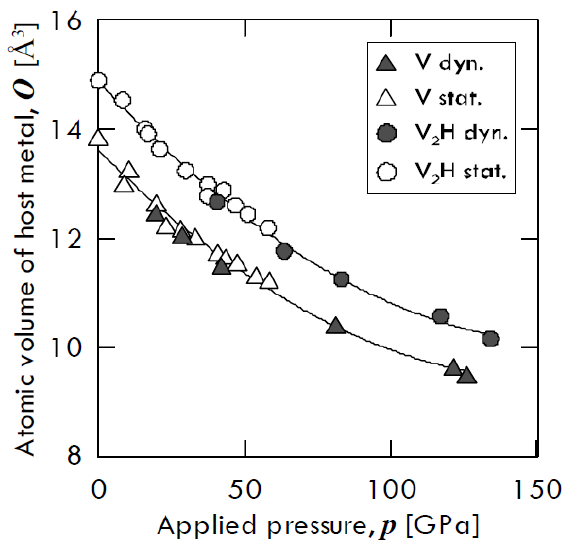
Figure 2. Compression curves of β -V 2 H and pure vanadium. The open symbols refer to static compression data (diamond anvil cell), while the closed ones refer to dynamic compression data (shock wave). Adapted from Fukai [13].